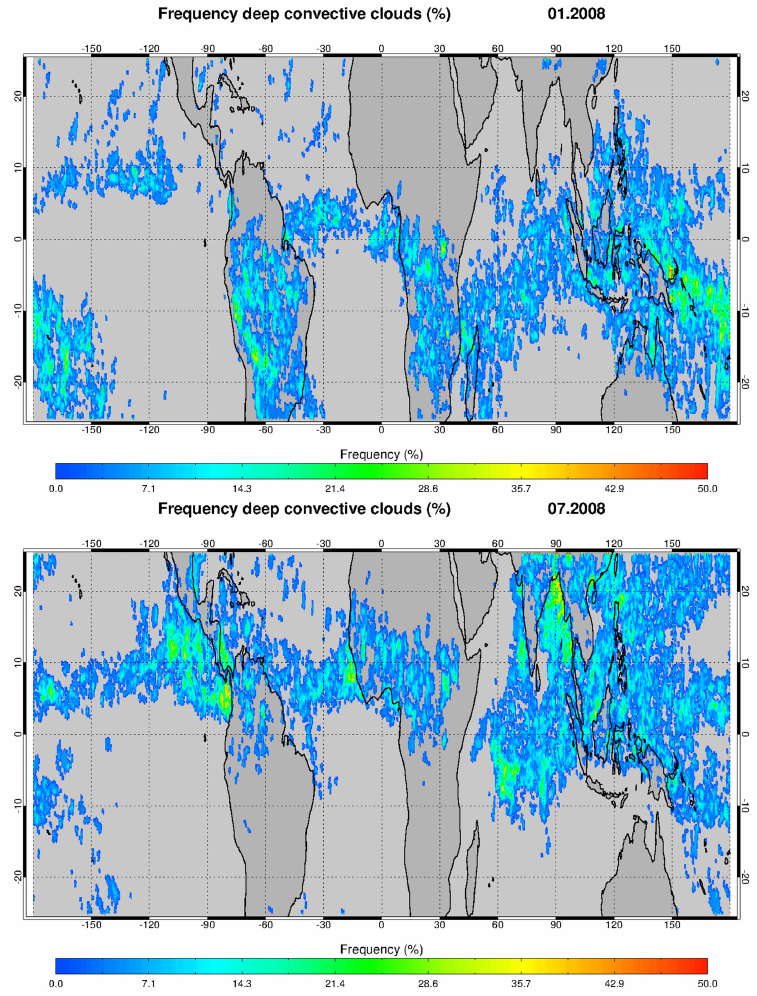
Figure 1. Frequency of occurrence of deep-convective clouds as derived from GOME-2 oxygen A band measurements using the OCRA/ROCINN algorithm. Results are shown for (top) January 2008 and (bottom) July 2008. Clouds are classified as deep convective if their tops are above the 300hPa level, the cloud albedo larger than 0.75, and their cloud fraction exceeds